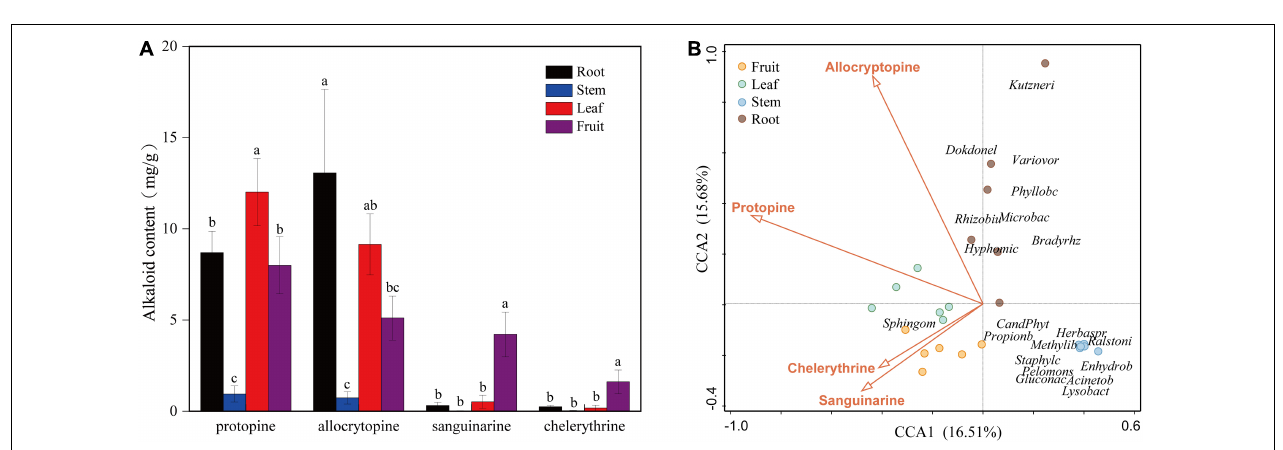
FIGURE 4 | (A) Contents of four kinds of alkaloids in different organs (fruit, leaf, stem, and root) of Macleaya cordata . (B) Canonical Correspondence Analysis (CCA) of the top 20 bacterial genera (with significant correlation coefficients) and four critical alkaloids in Macleaya cordata